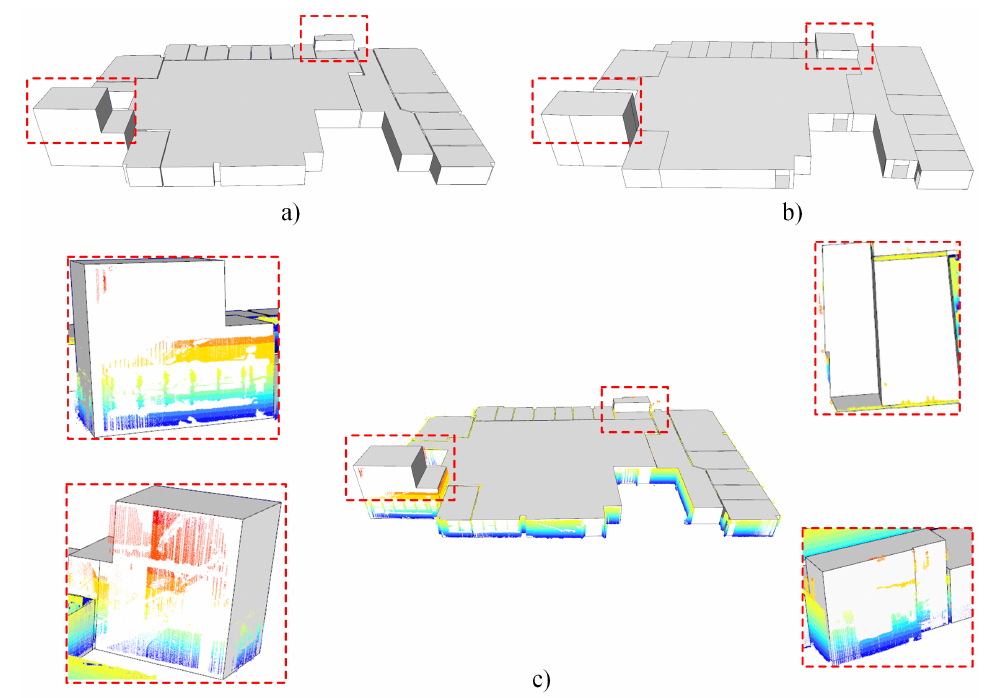
Figure 28. The comparison of different methods on mobile scanning data. ( a ) Reconstruction from our method, ( b ) reconstruction from decomposition and reconstruction of structural elements [17], and ( c ) enlarged detail of